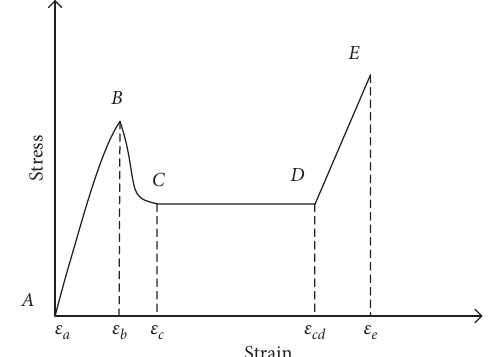
Figure 1: Honeycomb aluminum quasi-static compression be- havior (AB: elastic section; BD: plastic section; DE: densification